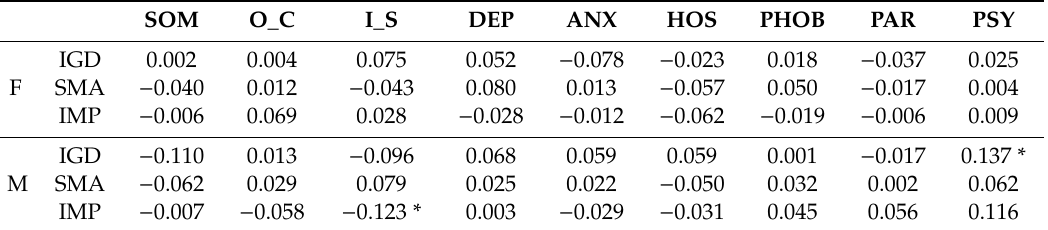
Table 6. Partial correlations between the variables of interest for gender